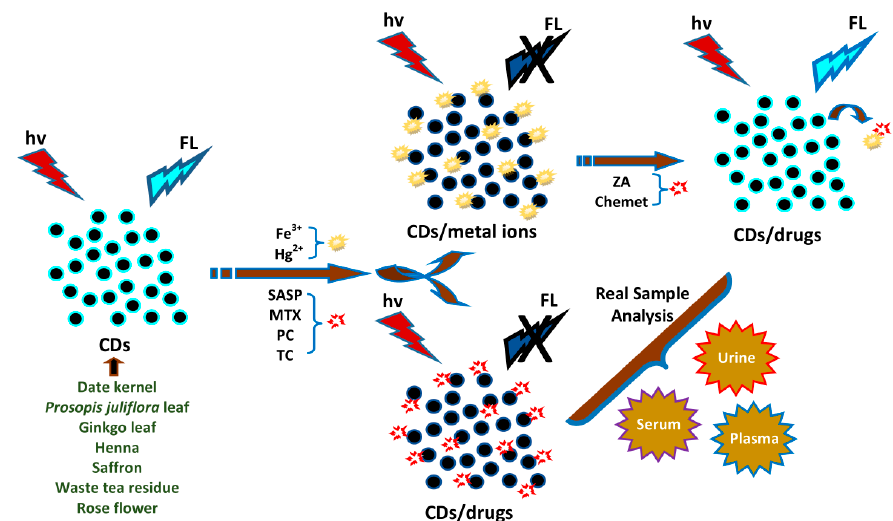
Figure 13. The schematic illustration of plant part-derived CDs for the sensing of drugs in biological samples. The enhancement of FL emission intensity in CD/Fe 3+ and CD/Hg 2+ was shown after interactions with ZA and chemet, respectively. The interaction of CDs with SASP, MTX, PC, and TC produced an FL quenching effect. The real sample analysis of all analytes was performed in different biological samples. Abbreviations: ZA, zoledronic acid; SASP, salazosulfapyridine; MTX, methotrexate; PC, prilocaine; TC, tetracycline.